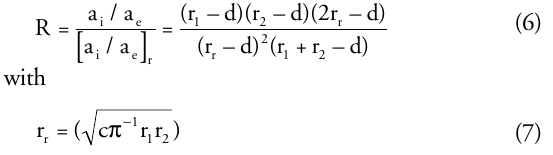
/a is observed for increasing z and i e